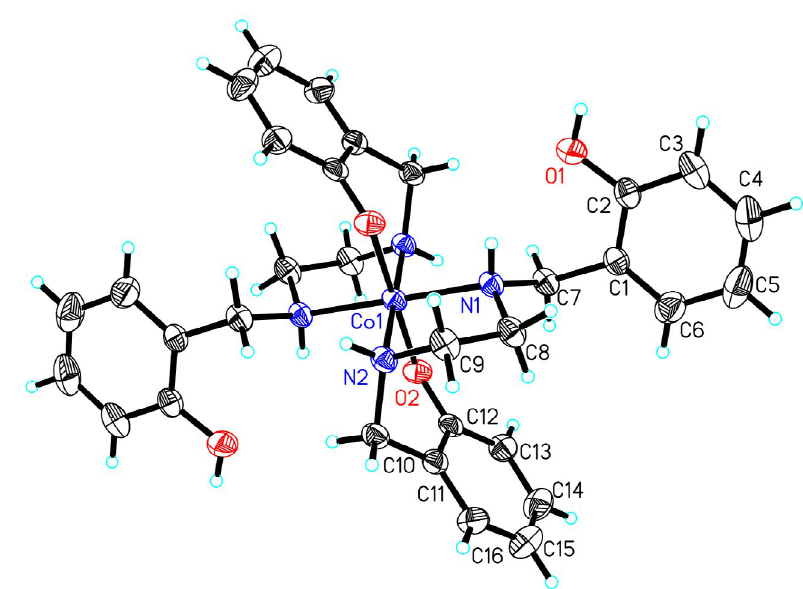
Fig. 1. The mononuclear complex cationic moiety of 1 . The chloride anion is omitted for clarity. Displacement ellipsoids are drawn at the 30% prob- ability level and H atoms are shown as small spheres of arbitrary